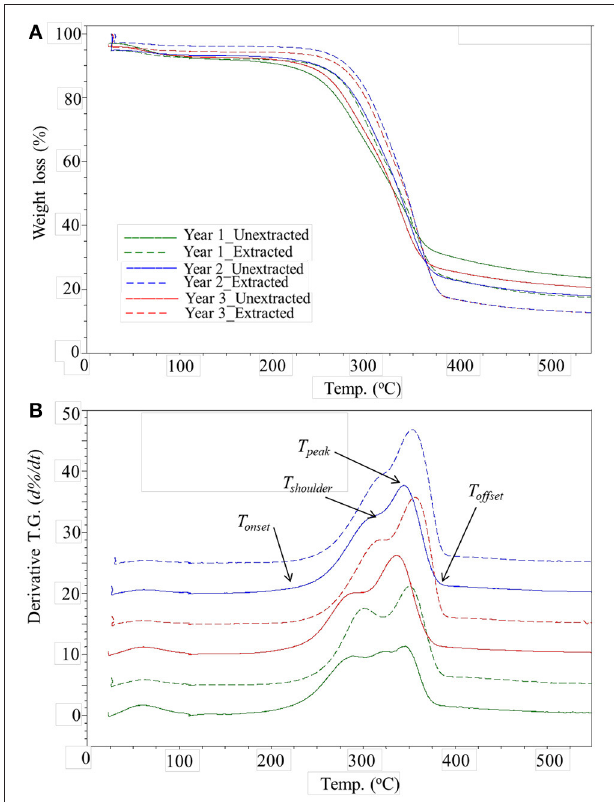
FIGURE 3 | Representative thermograms (A) and relative derivative TG curves (B) of the unextracted and extractives-free switchgrass samples of 3 consecutive harvesting years, with points noted for the onset, shoulder, peak, and offset temperatures, as defined by Grønli et al. (2002).